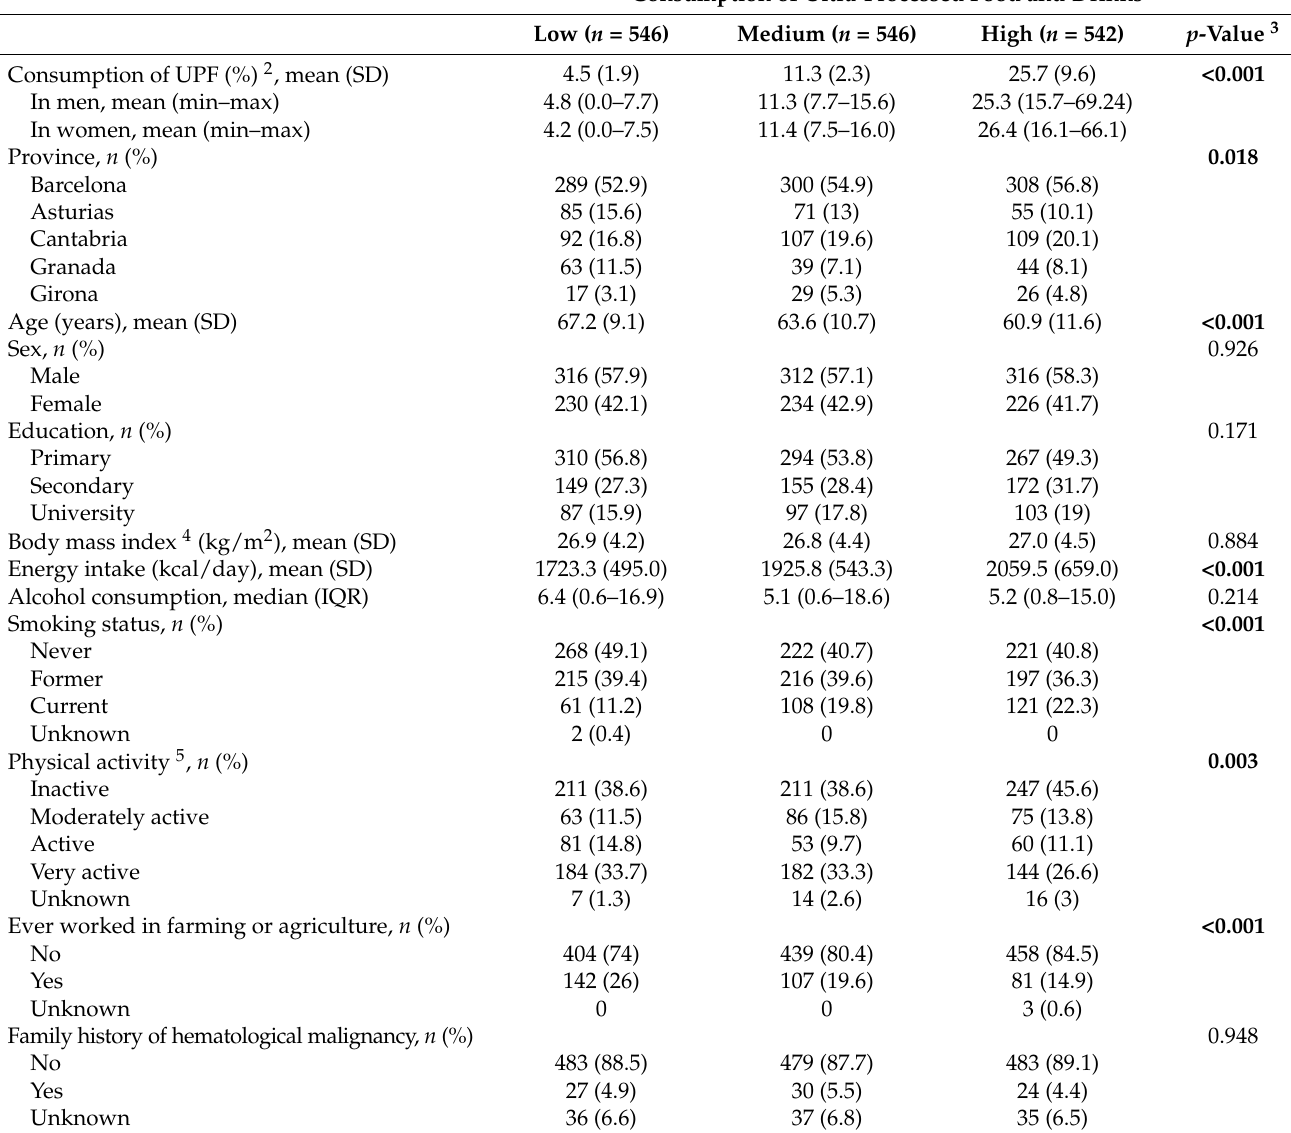
Table 2. Characteristics of participants in the control group according to the consumption of ultra-processed food (NOVA classification, group 4) in the MCC-Spain